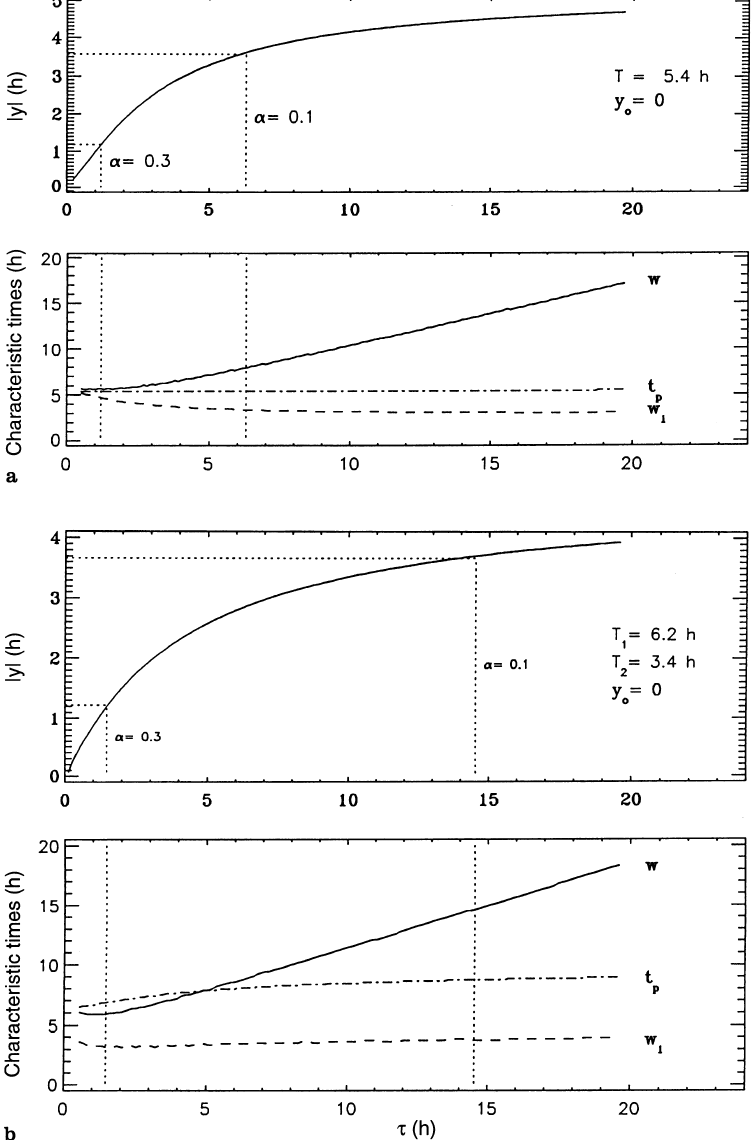
Fig. 5 for the triangular input), a(cid:128)ects the procedure.